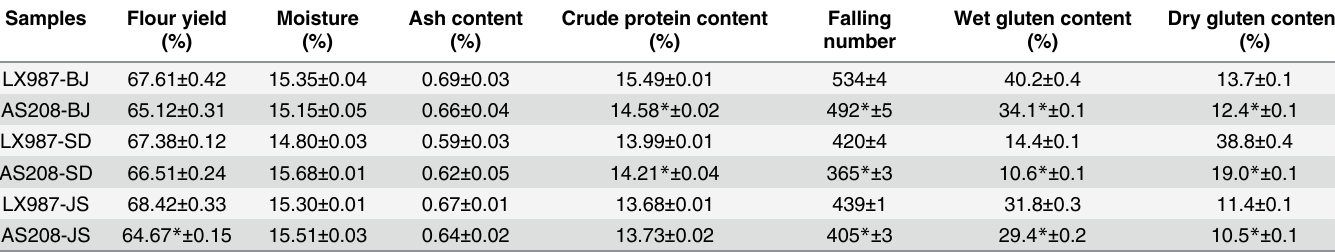
Table 3. Comparison of several quality parameters between AS208 and LX987. Samples